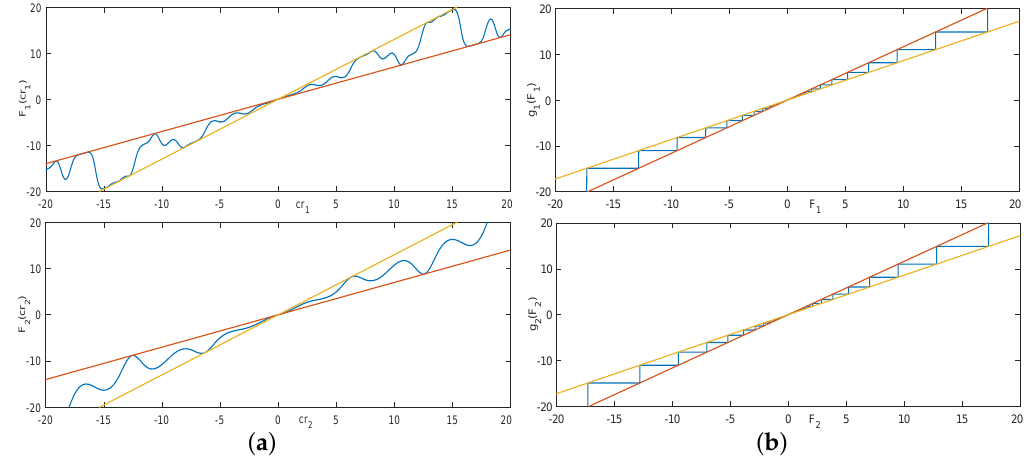
Figure 2. The functions of controller output nonlinearities. ( a ) The controllers’ inherent nonlinearity function F ( · ) . ( b ) The logarithmic quantizer function g ( · )